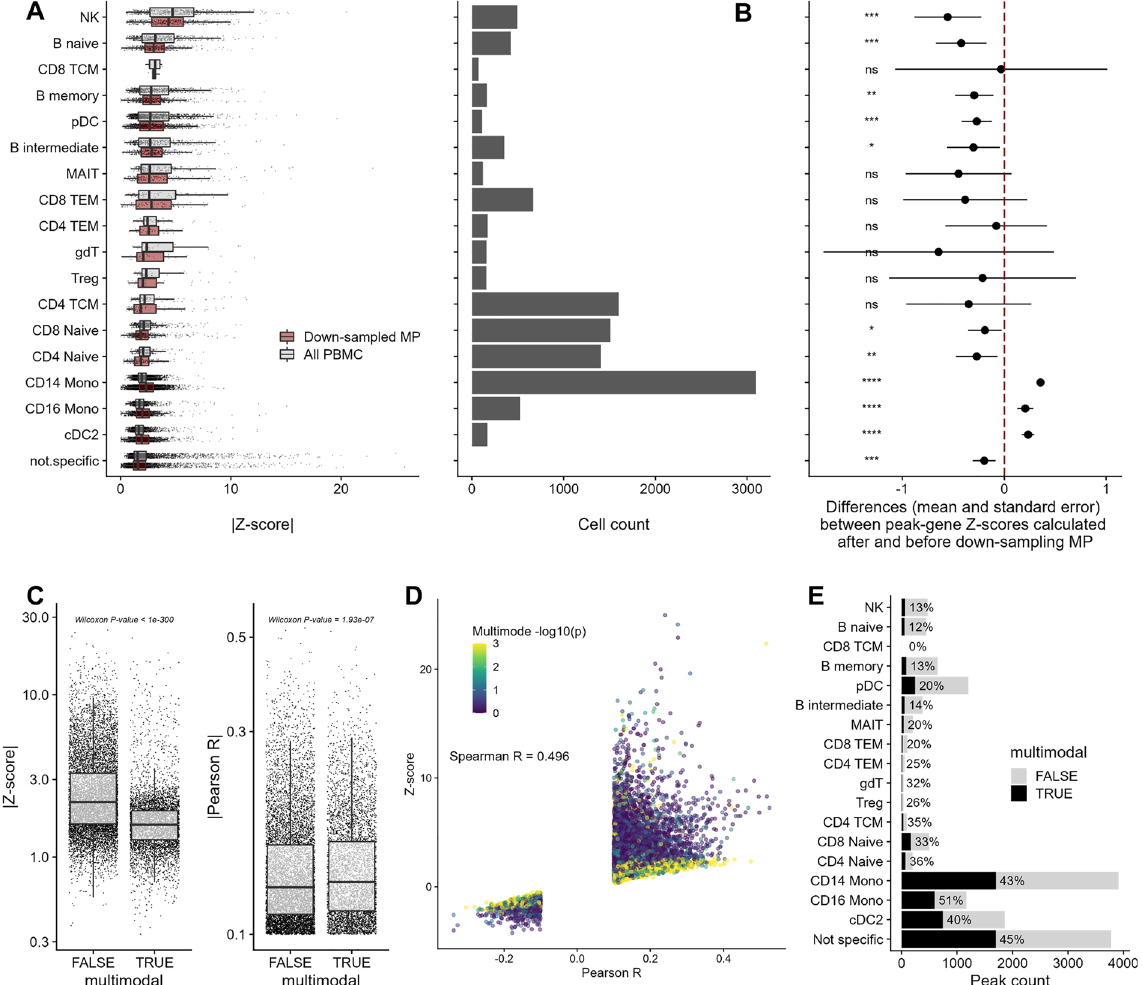
Figure 2. The cell-type composition of the PBMC single-nucleus multiomic dataset impacts the identification of gene-peak links using the Z-scores method. ( A ) Our analyses included 15,113 gene-peak links with |Pearson R|> 0.1 (Signac’s default parameter) identified in 30 cell-types. The left column shows the number of cells in each cell-type. In the right column, we show the boxplots of the statistics calculated using the Z-scores method. For this analysis, we assigned gene-peak links to specific cell-type using sensitivity and specificity metrics (“Methods”). Links that could not be unambiguously assigned are grouped in the “not.specific” category. We repeated the analyses by down-sampling the number of mononuclear phagocytes (MP) to n = 500. ( B ) Effect of down-sampling mononuclear phagocytes (MP) from 3,788 to 500 cells on peak-gene link statistics calculated with the Z-scores method. Positive values indicate higher Z-scores (i.e. more significant) after down-sampling. ns; not significant, *; P -value < 0.05, **; P -value < 0.01, ***; P -value < 0.001, ****; P -value < 0.0001. ( C ) The Z-score statistics and Pearson R coefficients for links between ATACseq peaks and target genes that generated uni- or multimodal null distributions (with the Z-scores method). ( D ) Scatterplot of the Pearson R coefficients ( x -axis) and statistics calculated with the Z-scores method ( y -axis) for all links between ATACseq peaks and target genes. Each point is color-coded based on the P -value of the multimode test. Peak-gene links that generated multimode null distributions (in yellow) tend to have Z-score statistics ~ 0 despite many having high Pearson R coefficients. ( E ) Proportion of multimodal null distributions by cell-type generated by the Z-scores method for the tested links between ATACseq peaks and target genes. Mono; Monocytes, cDC; classical Dendritic cells, NK; Natural killer cells, pDC; progenitor Dendritic cells, TEM; T effector memory cells, TCM; T central memory cells, gdT; Gamma delta (γδ) T cells, MAIT; mucosal-associated invariant T cells, Treg; regulatory T type-specific trans -peaks from the null distributions generally eliminated the bimodality and increased the Z-score statistics (Fig. 1C-D and Fig. S4). To better understand the effect of the bimodality on the Z-scores method, we tested each null distributions for multiple modes ( P -value < 0.05 for > 1 mode [“Methods”] 14 ) and compared the Z-scores and Pearson R coefficients of peak-gene links obtained for multimodal and unimodal null distributions. Whereas statistics from the Z-scores method were significantly lower for peak-gene links with multimodal null distributions (Wilcoxon P -value < 1 × 10 –300 ), we found that the simple Pearson R statistics